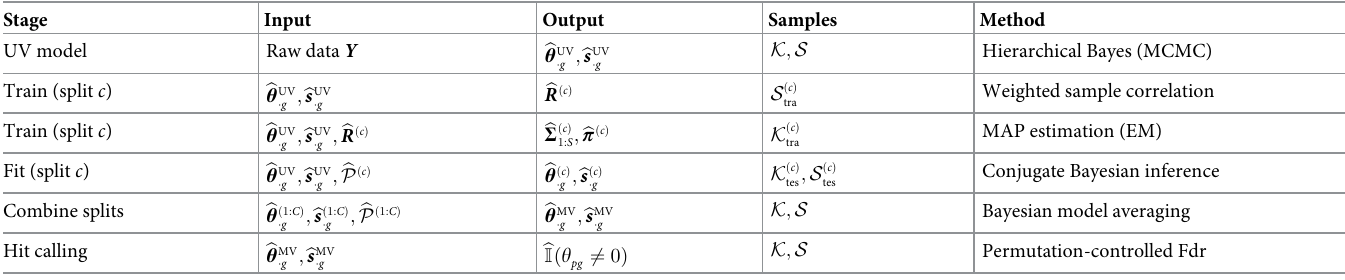
Table 5. Cross-validated empirical Bayes inference.